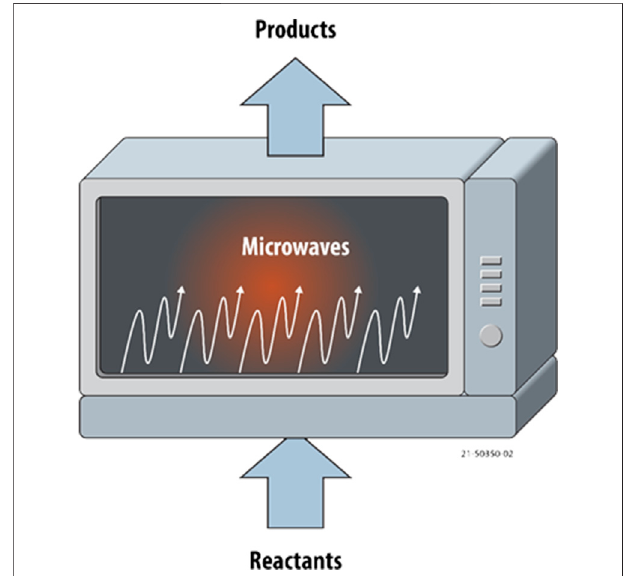
FIGURE 8 | Microwave reactor for biomass